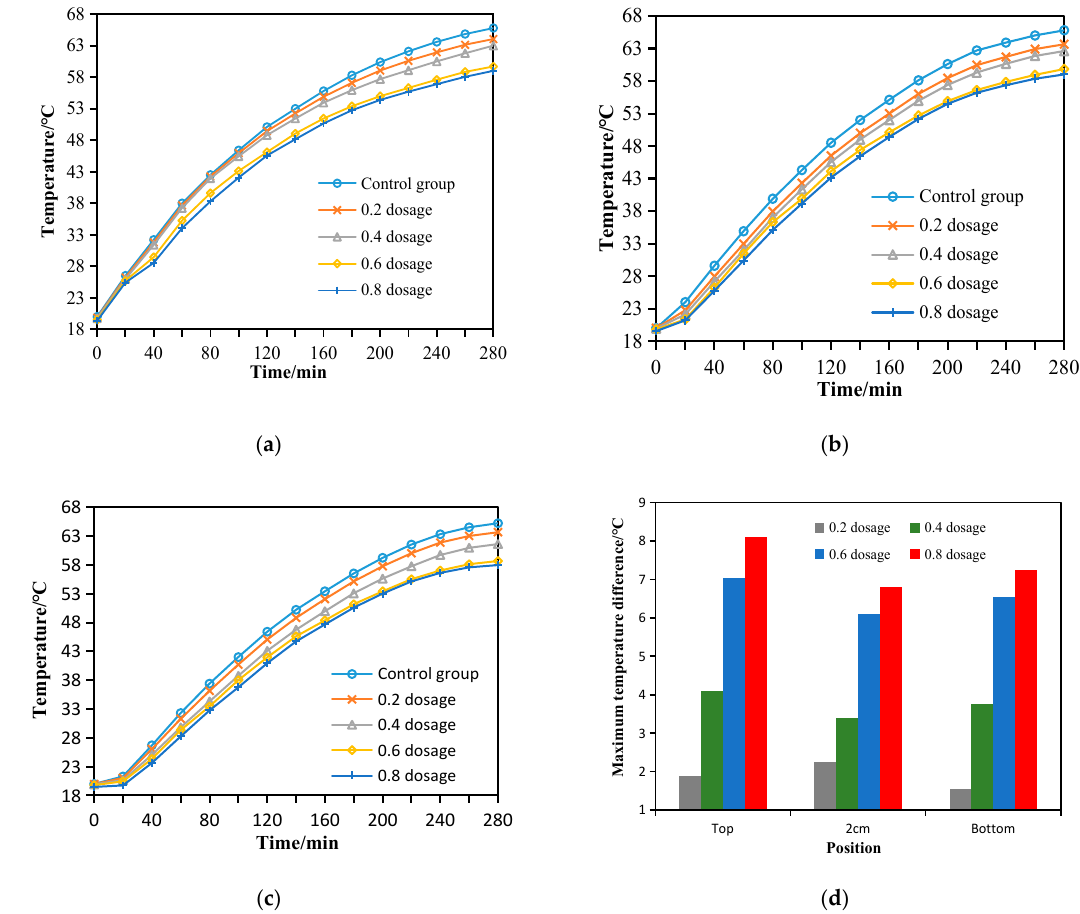
Figure 14. Cooling performance of different dosages of coating: ( a ) The upper surface temperature of the specimen; ( b ) Temperature at 2 cm of the specimen; ( c ) Temperature at the bottom of the specimen; ( d ) Maximum temperature difference with the control group.